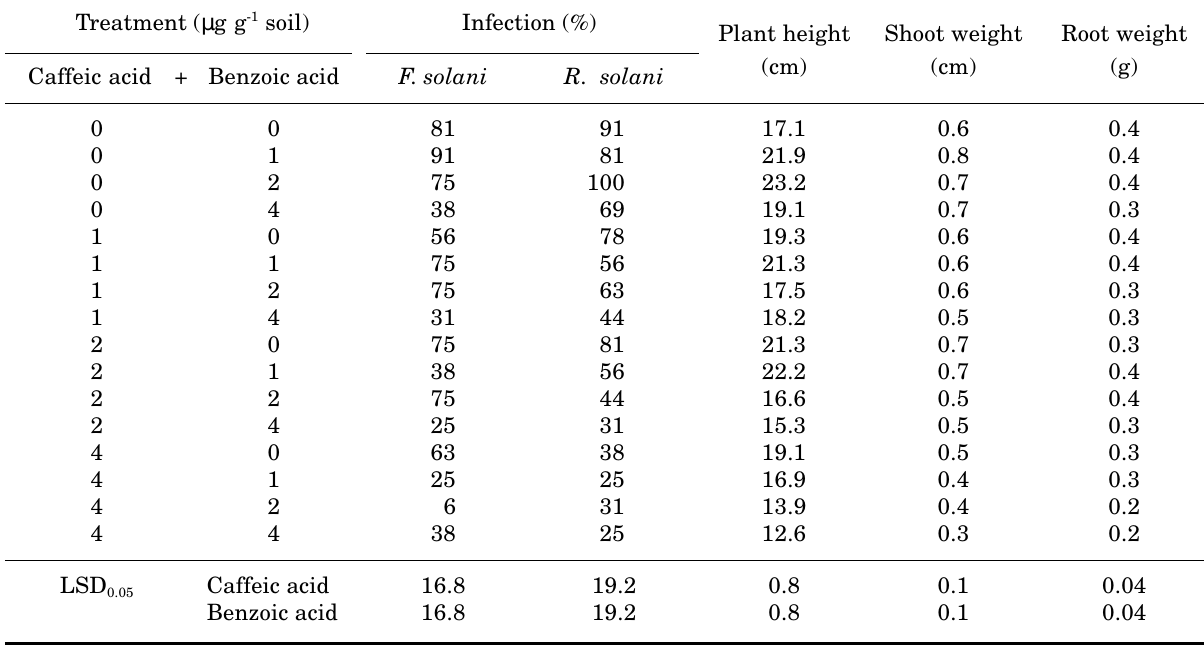
Table 1. Effect of mixtures of phenolic acids on Fusarium solani and Rhizoctonia solani and on growth of mungbean. Treatment ( µ g g -1 soil) Infection (%) Plant height Shoot weight Root weight Caffeic acid + Benzoic acid F.